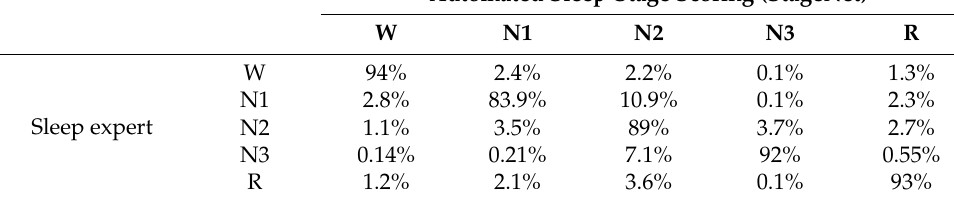
Table 1. Confusion